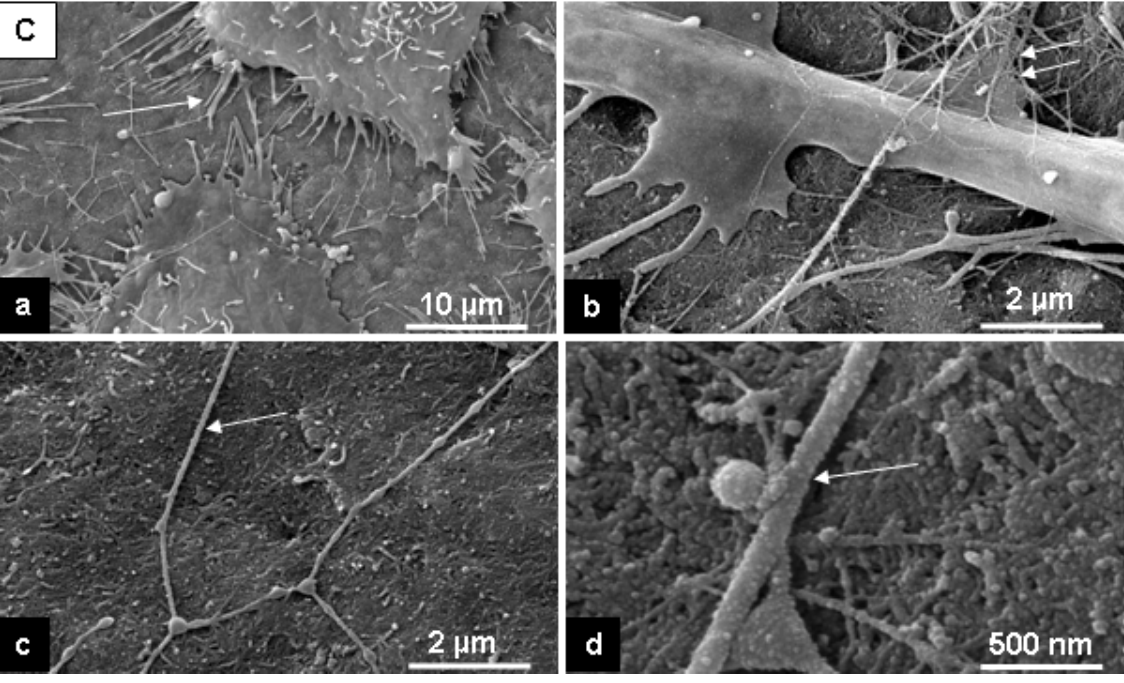
Figure 4. Representative SE-microscopic images of cell behavior on the C-nanostructured surfaces (nanotubes) after 24 hours of cultivation. Note: cell filopodia by cell-substrate contacts (a, arrow), cell traces (c and d, arrow) and a fine filaments network on the substrate and over the cell surface (b, double